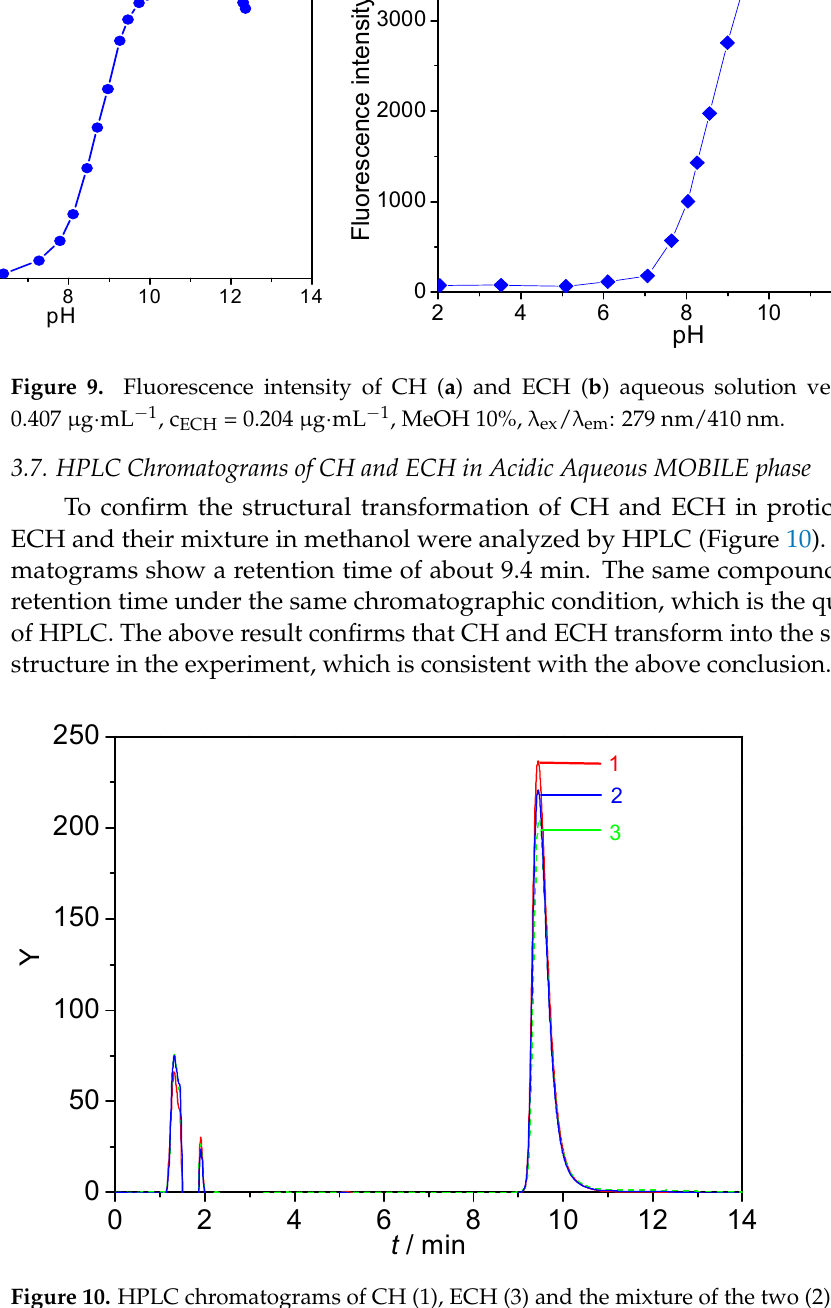
Figure 10. HPLC chromatograms of CH (1), ECH (3) and the mixture of the two (2).